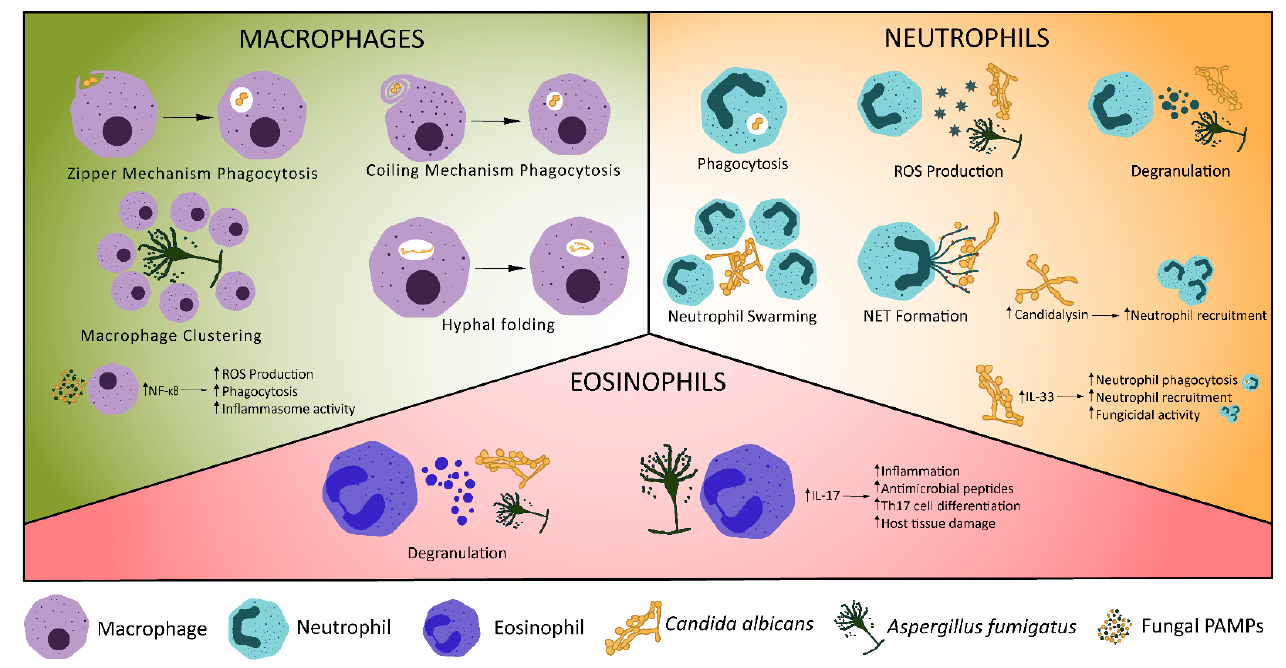
Figure 1. Cellular Innate Immune Control of Fungal Infections. Various mechanisms exist for the control of fungal infections by the innate immune system. Macrophages phagocytose fungi, undergo macrophage clustering or fold phagocytosed hyphae. Recognition of fungal ligands, such as candidalysin, stimulates production of IL ‐ 1 β , triggering neutrophil recruitment [70]. Increased expression of IL ‐ 33 in C. albicans infection triggers neutrophil recruitment and phagocytosis [71]. Neutrophils may also release reactive oxygen species (ROS) or neutrophil extracellular traps, degranulate, phagocytose fungi or undergo swarming. Eosinophils have antifungal effects through degranulation [72] and production of IL ‐ 17, which stimulates pro ‐ inflammatory signalling, production of antimicrobial peptides and Th17 cell differentiation [73,74].